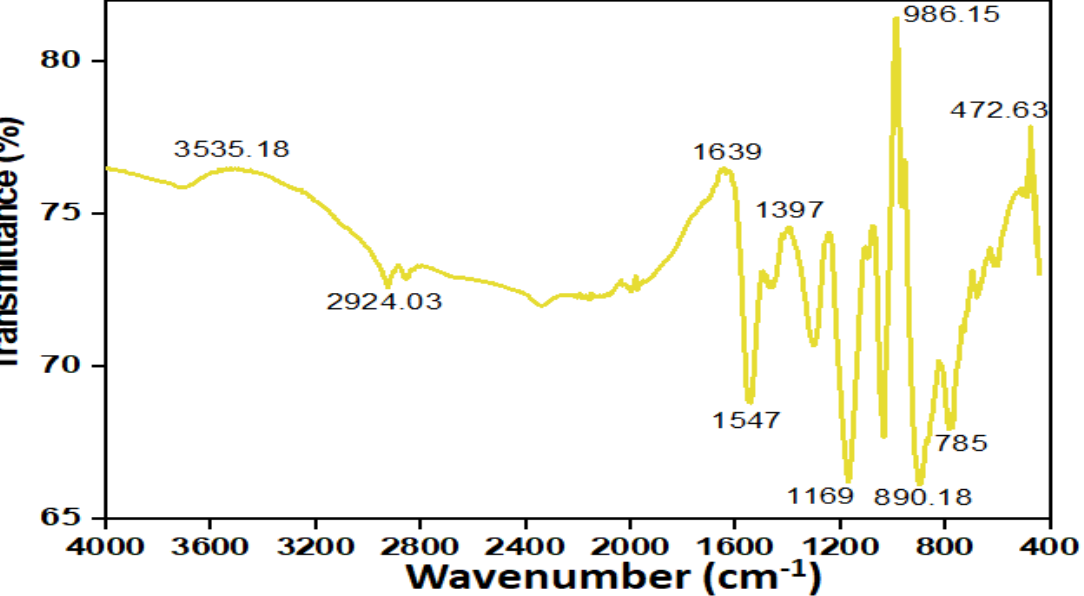
Figure 3. FTIR spectra of synthesed polypyrrole-polyethyleneimine (PPy-PEI)